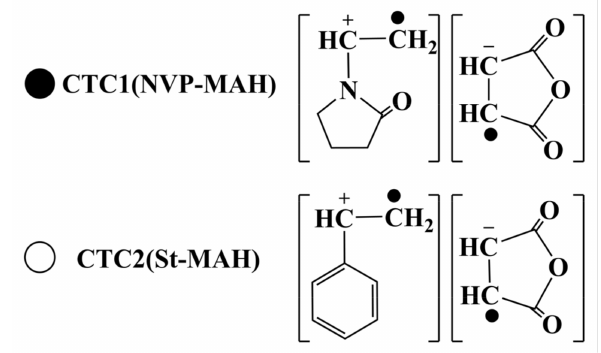
Figure 1. The CTC structure formed by MAH with NVP and St, respectively.